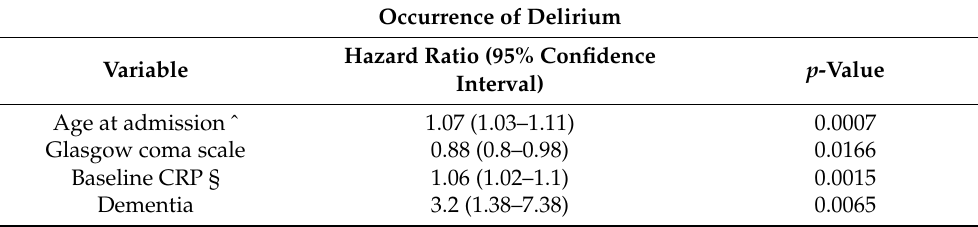
Table 4. Variables associated with delirium occurrence in the multivariable model.